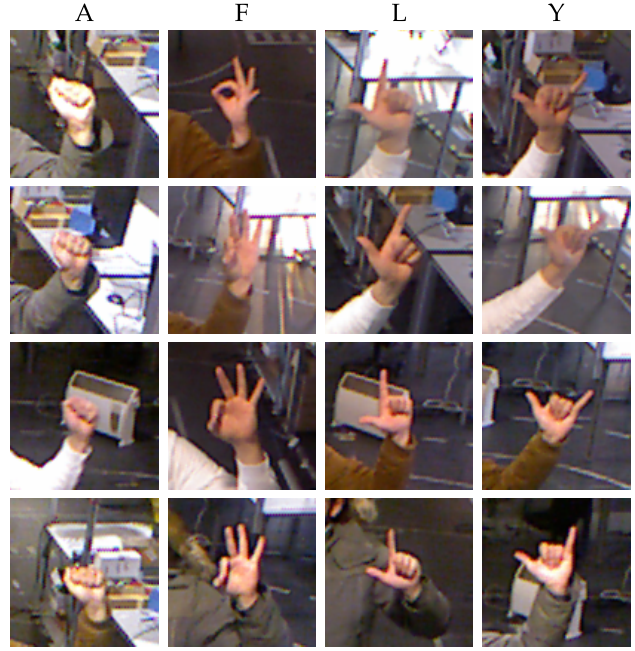
Figure 3. Examples of the training dataset of the four hand gesture classes in the unstructured environment and complex background. Each column is a class that is associated with an American Sign Language letter.